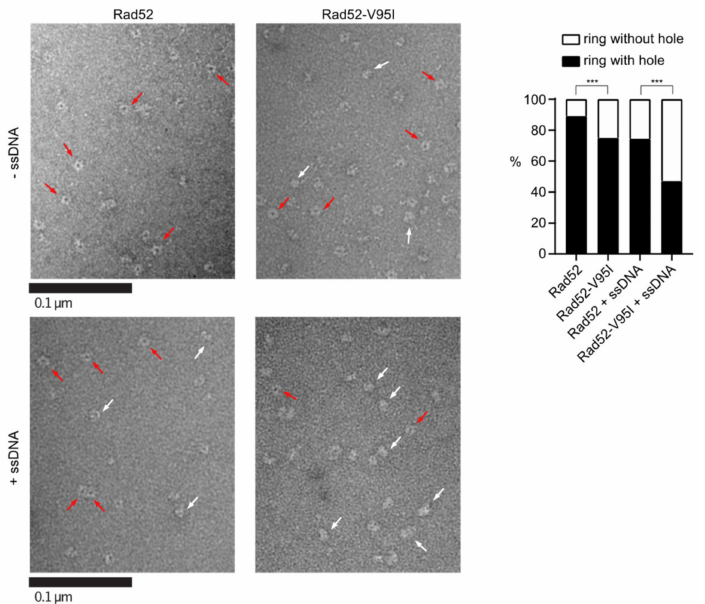
Figure 5. EM analysis of Rad52 and Rad52-V95I without DNA (upper panels) or with 400nt-ssDNA (lower panels). All experiments were performed with FLAG-tagged Rad52 proteins. The protein- ssDNA complex was formed at a ratio of 1:20 nucleotides. Some representative rings with hole (red arrows) and without hole (white arrows) are shown. The percentage of each molecular species is plotted on the histogram (right panel). Two independent experiments were performed with very similar results. The results of the individual biological replicates were pooled (933 molecules analyzed); *** p < 0.001 (two-tailed Fisher’s exact test).